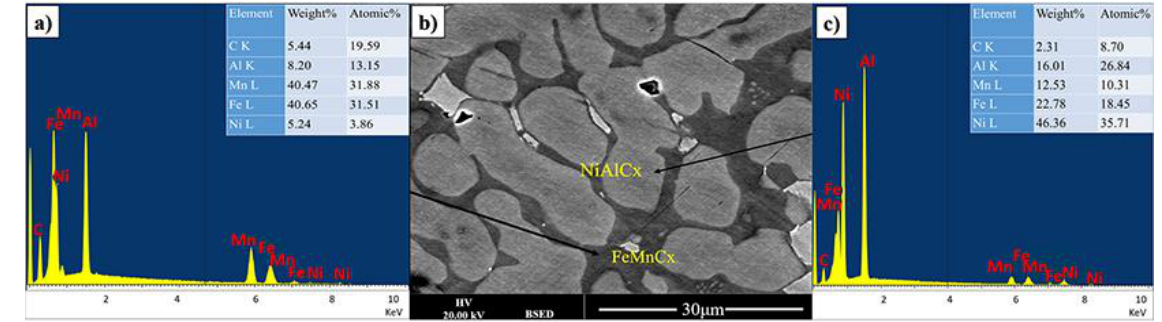
Figure 2. ( b ) BSE image, ( a , c ) are EDX spectrum from two main phases of FeMnNiAlC 10 bulk alloy processed by arc melting.